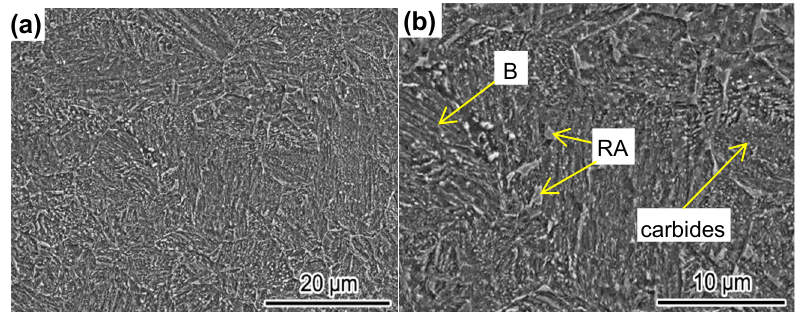
Figure 4. The microstructure of cold-rolled plates after continuous annealing. ( a ) Low amplification; ( b ) high magnification.